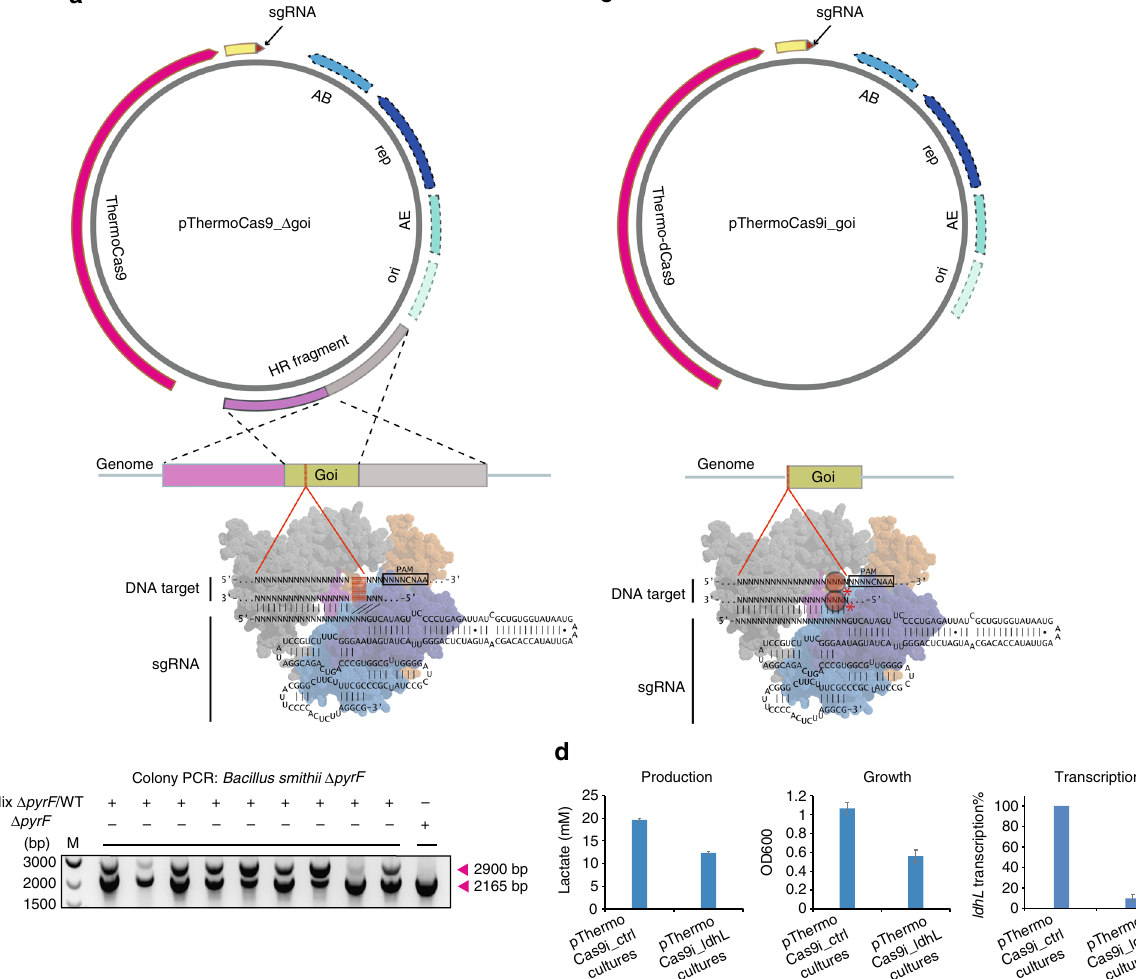
Fig. 5 ThermoCas9-based genome engineering in prokaryotes. a Schematic overview of the basic pThermoCas9_ Δ gene-of-interest (goi) construct. The thermocas9 gene was introduced either to the pNW33n ( B. smithii ) or to the pEMG ( P. putida ) vector. Homologous recombination fl anks were introduced upstream thermocas9 and encompassed the 1 kb ( B. smithii ) or 0.5 kb ( P. putida ) upstream and 1 kb or 0.5 kb downstream region of the gene of interest (goi) in the targeted genome. A sgRNA-expressing module was introduced downstream the thermocas9 gene. As the origin of replication (ori), replication protein (rep), antibiotic resistance marker (AB) and possible accesory elements (AE) are backbone speci fi c, they are represented with dotted outline. b Agarose gel electrophoresis showing the resulting products from genome-speci fi c PCR on ten colonies from the ThermoCas9-based pyrF deletion process from the genome of B. smithii ET 138. All ten colonies contained the Δ pyrF genotype and one colony was a clean Δ pyrF mutant, lacking the wild- type product. Supplementary Fig. 13 shows the uncropped gel image. c Schematic overview of the basic pThermoCas9i_goi construct. Aiming for the expression of a catalytically inactive ThermoCas9 (ThermodCas9: D8A, H582A mutant), the corresponding mutations were introduced to create the thermodcas9 gene. The thermodcas9 gene was introduced to the pNW33n vector. A sgRNA-expressing module was introduced downstream the thermodcas9 . d Graphical representation of the production, growth and RT-qPCR results from the ldhL silencing experiment using ThermodCas9. The graphs represent the lactate production, optical density at 600 nm and percentage of ldhL transcription in the repressed cultures compared to the control cultures. Average values from three biological replicates are shown, with error bars representing